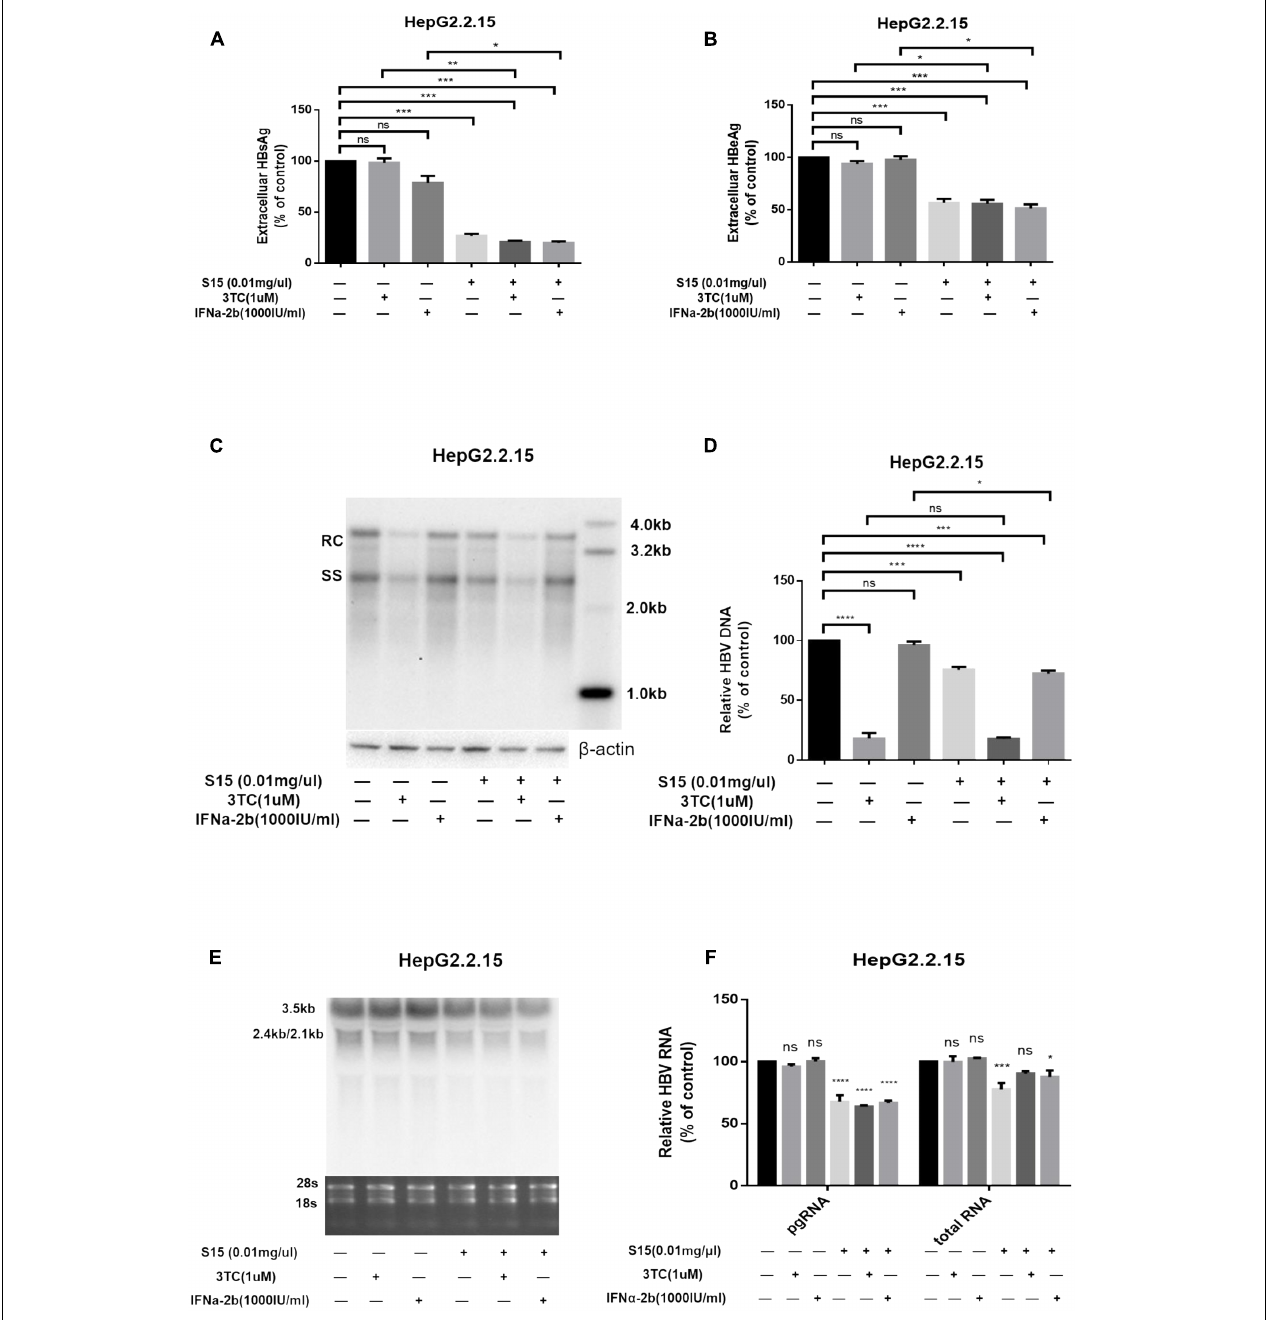
FIGURE 3 | Lettuce extracts S15 suppresses HBV viral antigen secretion (A,B) , replication (C,D) and transcription (E,F) in the absence or presence 3TC and IFNa-2b in HepG2.2.15 cells. HBsAg and HBeAg levels in culture supernatants were measured using an electrochemical illuminescent immunoassay (A,B) . HBV replication intermediates were extracted and detected by Southern blot hybridization (C) and quantified using fluorescence quantitative PCR (D) . Viral RNAs were examined by Northern blot (E) and quantified using fluorescence quantitative PCR (F) . All values are expressed as percentages relative to untreated control. RC, relaxed circular DNA; SS, single-stranded DNA. β -actin served as the DNA loading control and 18S/28S RNAs served as the RNA loading control. Statistical significance was calculated using student’s t -test. Ns, not significant, ∗ P < 0.05, ∗∗ P < 0.005, ∗∗∗ P < 0.0005, ∗∗∗∗ P <